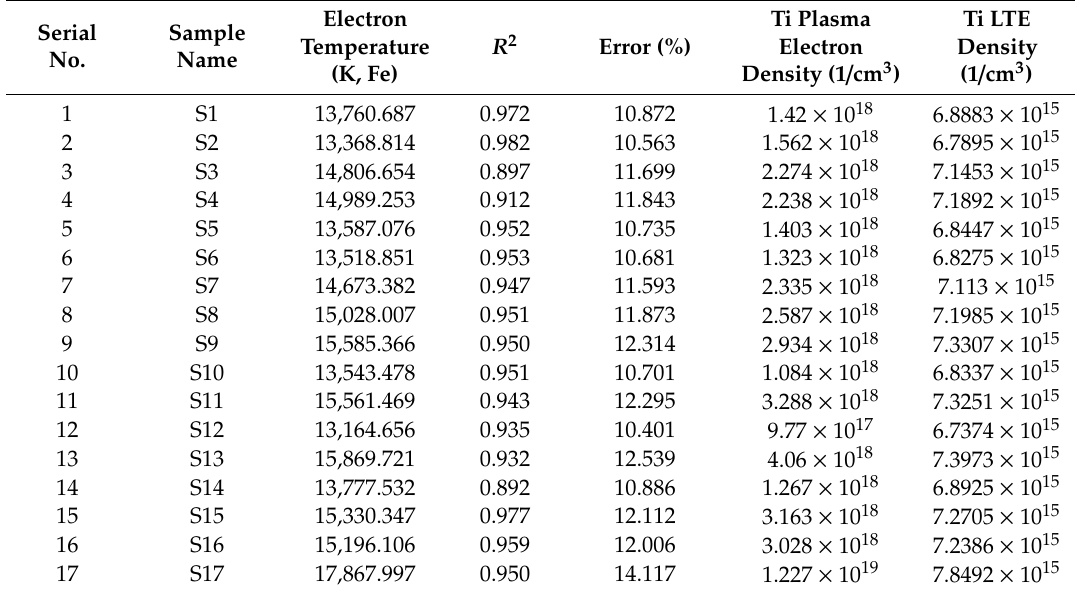
Table 2. Plasma electron temperature and plasma electron density of the samples during